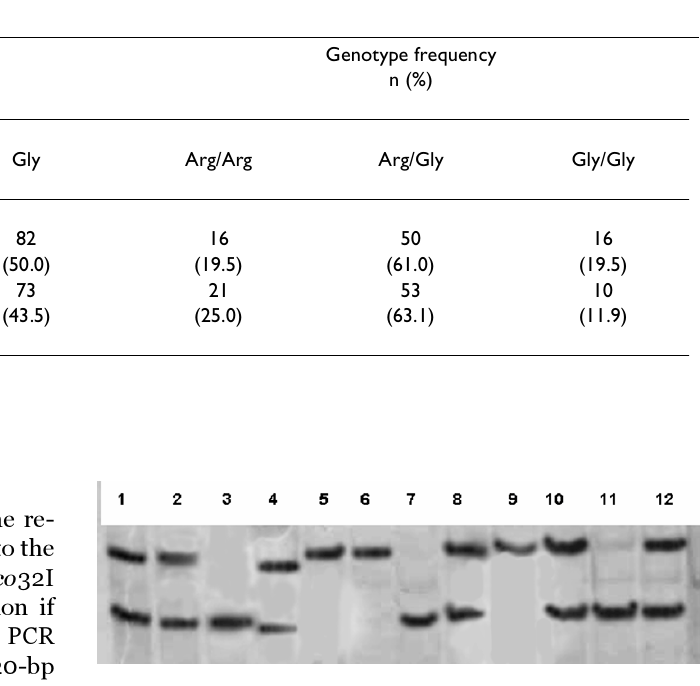
Figure 2 Restriction analysis of Arg213Gly polymorphism at the SOD3 gene. Lanes 1-3, 5-12: 11 samples after digestion with Eco 521; lanes 3, 7, and 11, Arg/Arg genotype; lanes 1, 2, 8, 10, and 12, Arg/Gly genotype; lanes 5, 6, and 9, Gly/Gly geno- type. Lane 4: molecular weight DNA marker pBR322/ Msp I 90- and 76-bp DNA fragments are